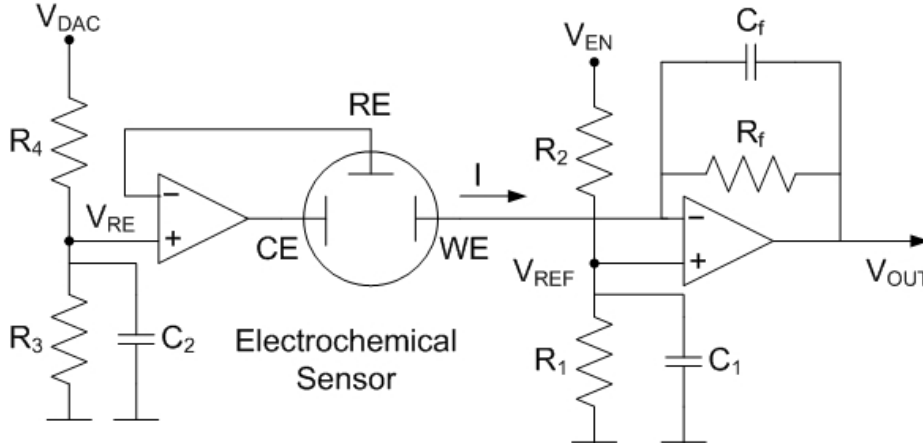
Figure 13. Electrical scheme of the